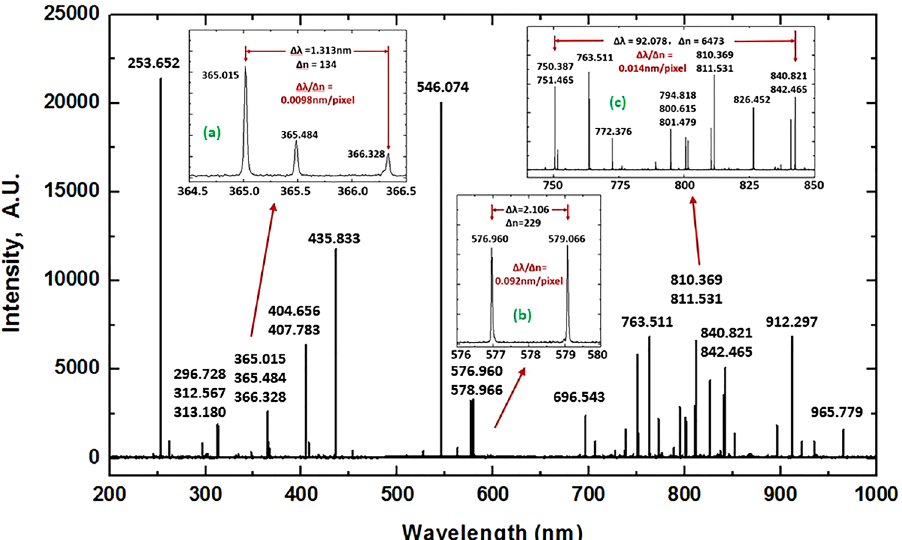
Figure 3. The spectrum of dual-element Hg–Ar light source which was applied to measure the wavelength lines in the 200–1000 nm spectral region, wherein the insets show magnified views of the well-resolved triple and twin spectral lines of elemental Hg and other spectral lines of elemental